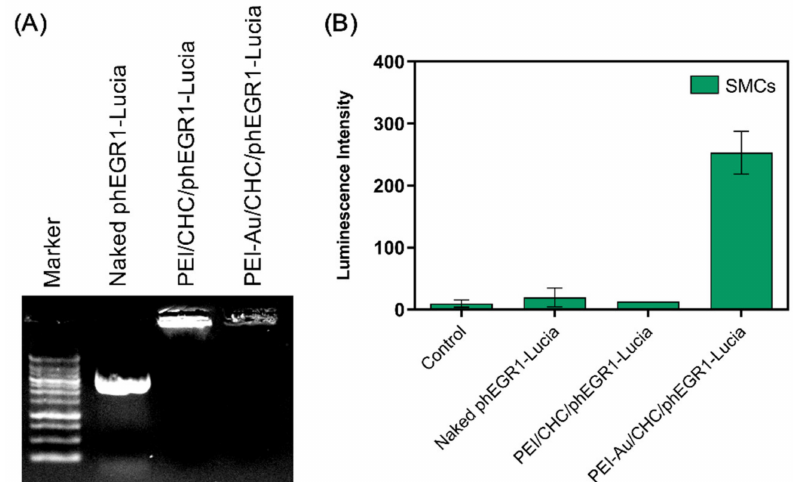
Figure 4. ( A ) The encapsulation ability of the polyethylenimine / carboxymethyl hexanoyl chitosan (PEI / CHC) and Au cluster-incorporated polyethylenimine / carboxymethyl hexanoyl chitosan (PEI-Au / CHC) vehicles for the phEGR1-Lucia gene. The condensation e ff ects of the PEI / CHC vehicle and PEI-Au / CHC vehicle on DNA were investigated using electrophoresis on 1.2% agarose gel with Tris-acetate (TAE) running bu ff er at 80 V for 25 min. DNA was visualized with EtB “Out” nucleic acid staining solution. ( B ) In vitro transfection e ffi ciency of the PEI / CHC / phEGR1-Lucia complex and PEI-Au / CHC / phEGR1-Lucia